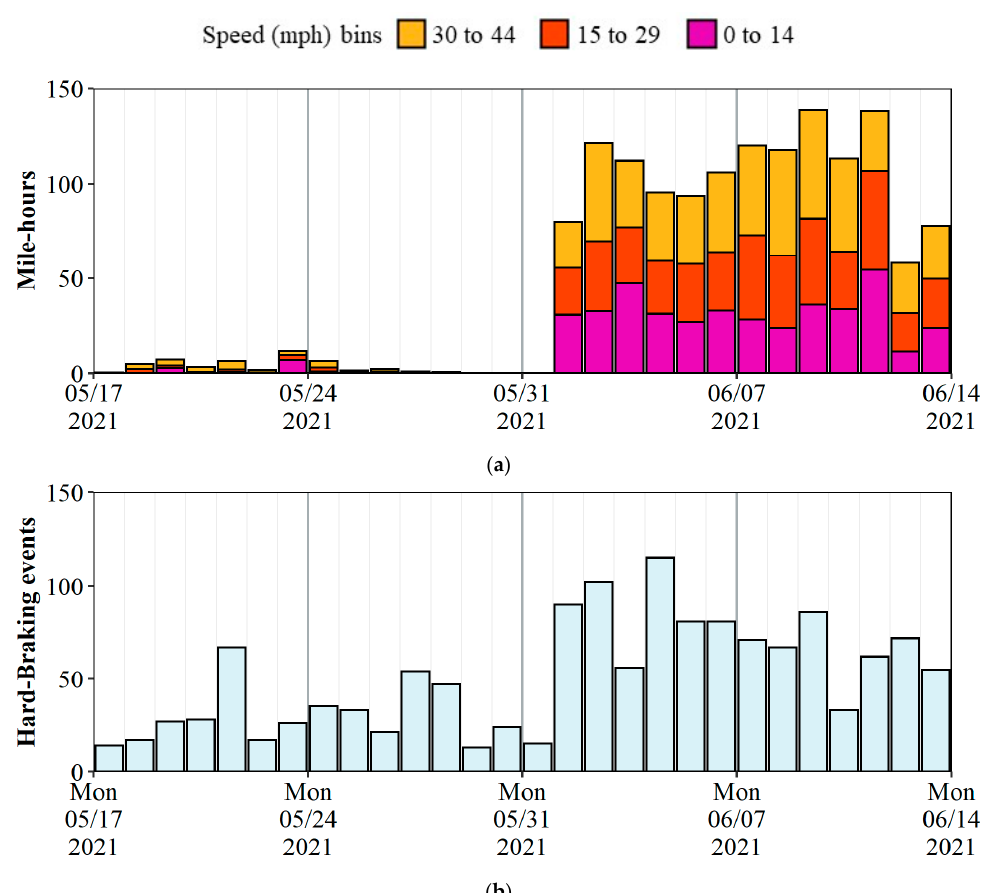
Figure 12. Daily mile–hours of congestion and hard-braking events before and during the construc- tion period along I-70 EB (MM 90–MM 125) in Greenfield district. ( a ) Daily mile–hours of congestion by speed bins; ( b ) Daily hard-braking events.